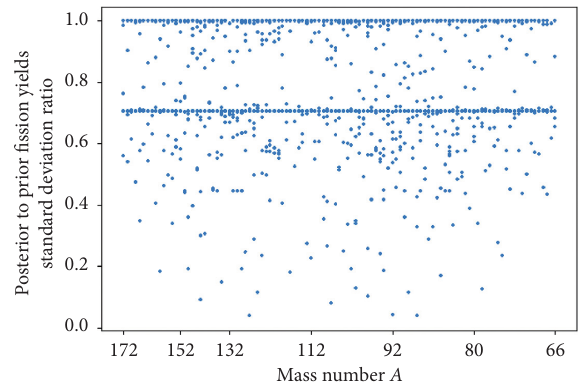
Figure 10: Posterior to prior fission yields standard deviation ratios. These fission products are grouped with their corresponding mass number and the first mass numbers are labelled in this